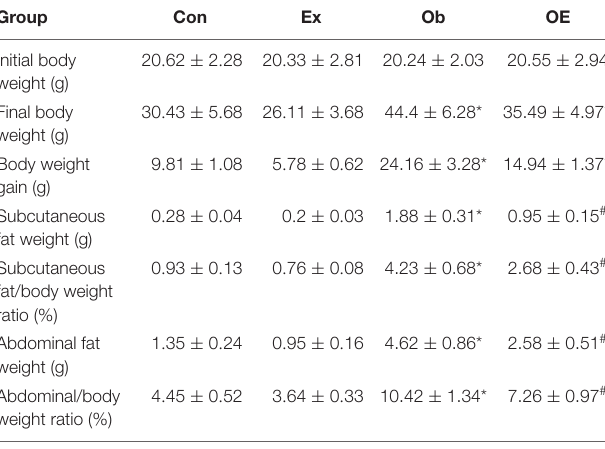
TABLE 2 | Effects of HFD and exercise on body mass and body